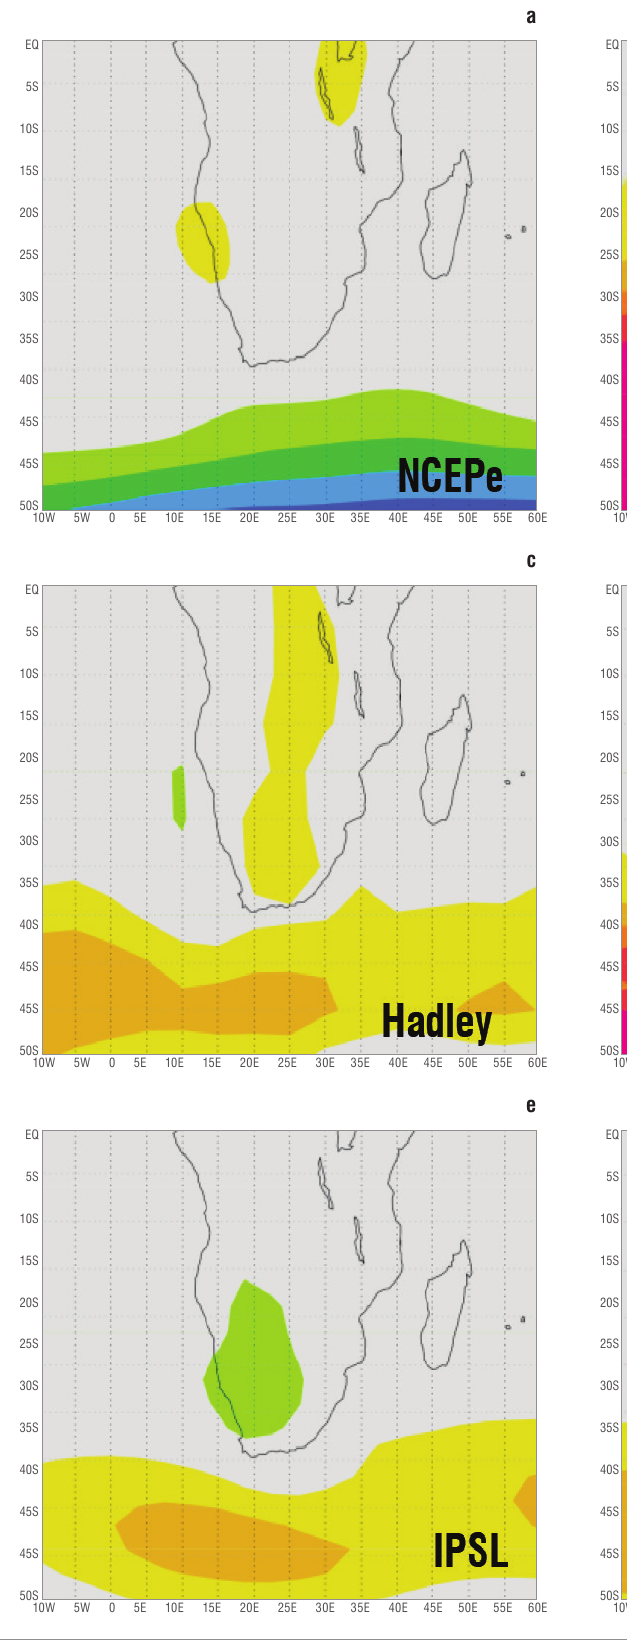
Note: scales for model simulations differ. Circles in (f) are key points analysed in Figure 5. Figure 4: Sea level pressure trends (mb/year) over southern Africa obtained through linear regression for (a and c) 1900–2010, (b) 1958+, (d) 1979+, and (e and f)